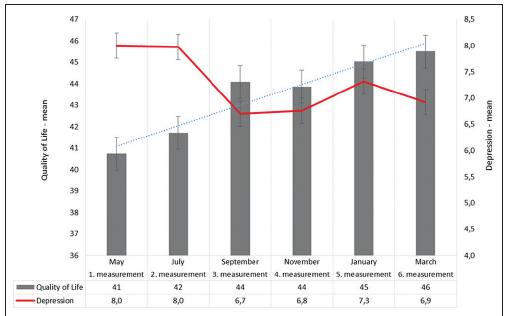
FIGURE 3. Graphical representation of a relationship between the quality of life and depression in